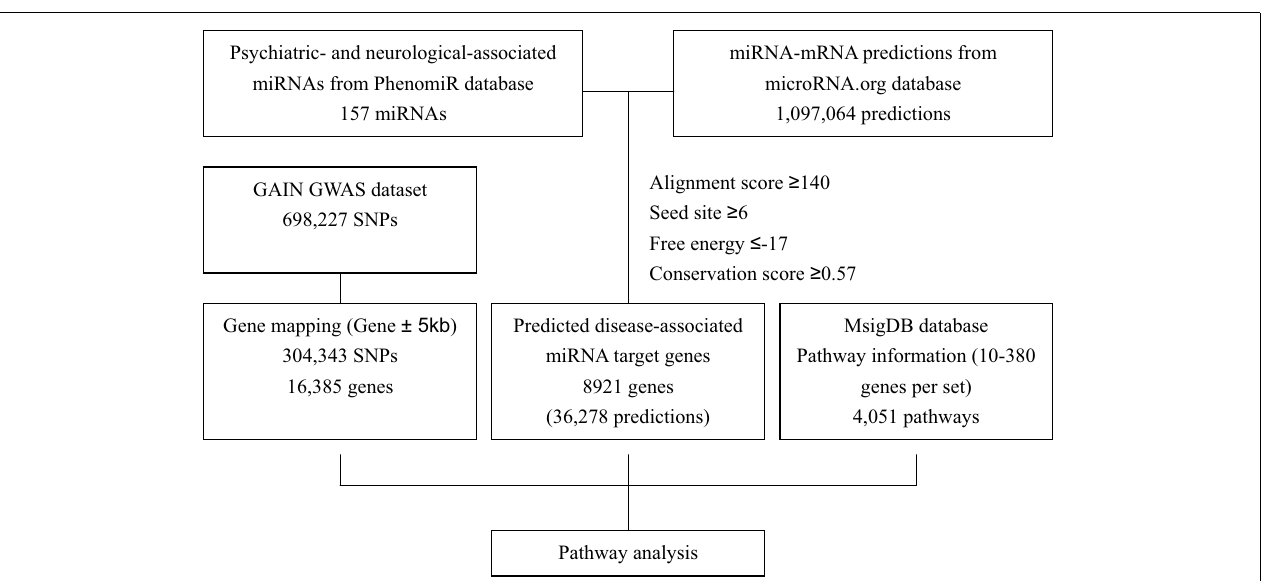
FIGURE 1 |The flowchart of identification of psychiatric- and neurological-associated miRNAs and their target genes and information for pathway analysis.